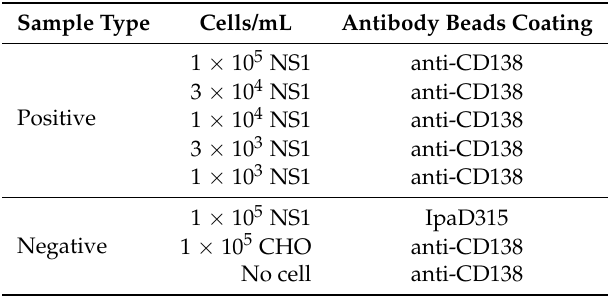
Table 1. Summary of used